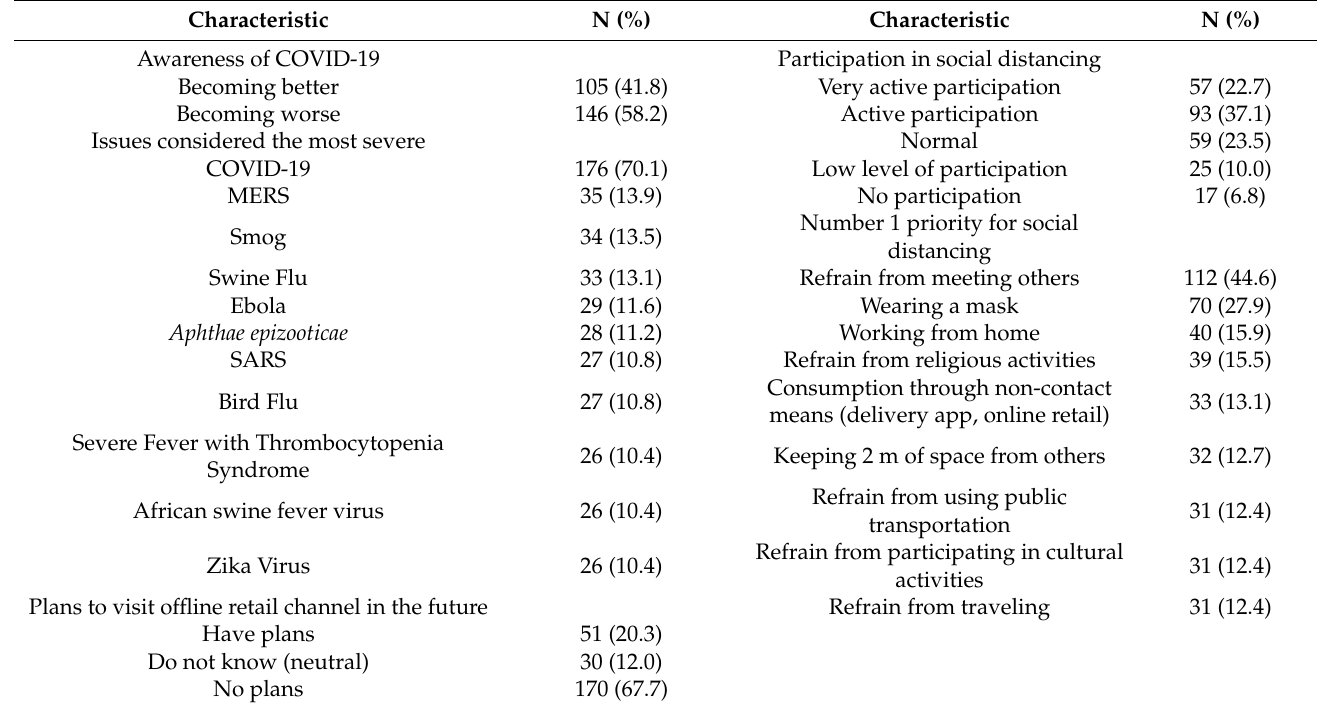
Table 2. Awareness of COVID-19.